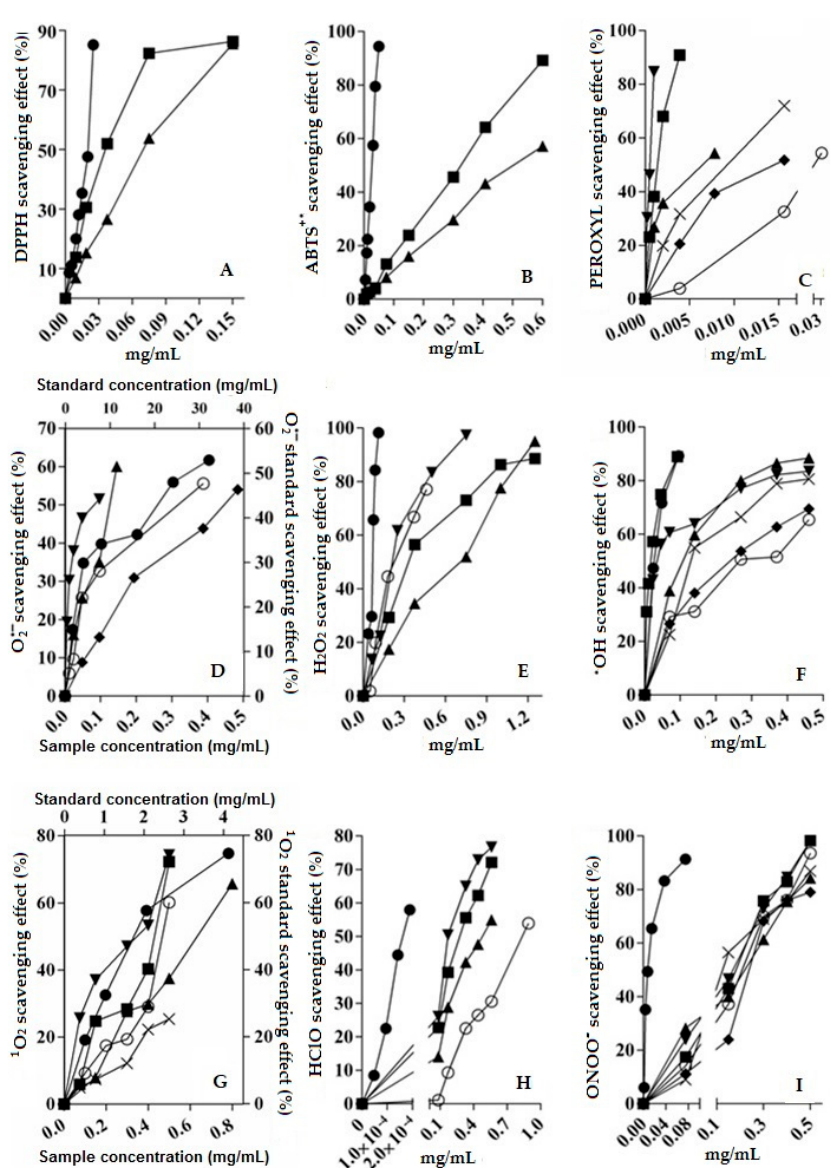
Figure 3. Antioxidant properties of the extracts and the marker compounds (3)–(6) of V. carolina . DPPH (panel A ), ABTS (panel B ), ROO ● (panel C ), O 2 ●− (panel D ), H 2 O 2 (panel E), OH ● (panel F), 1 O 2 (panel G), HClO (panel H), ONOO − (panel I), scavenging capacity of the methanolic extract (